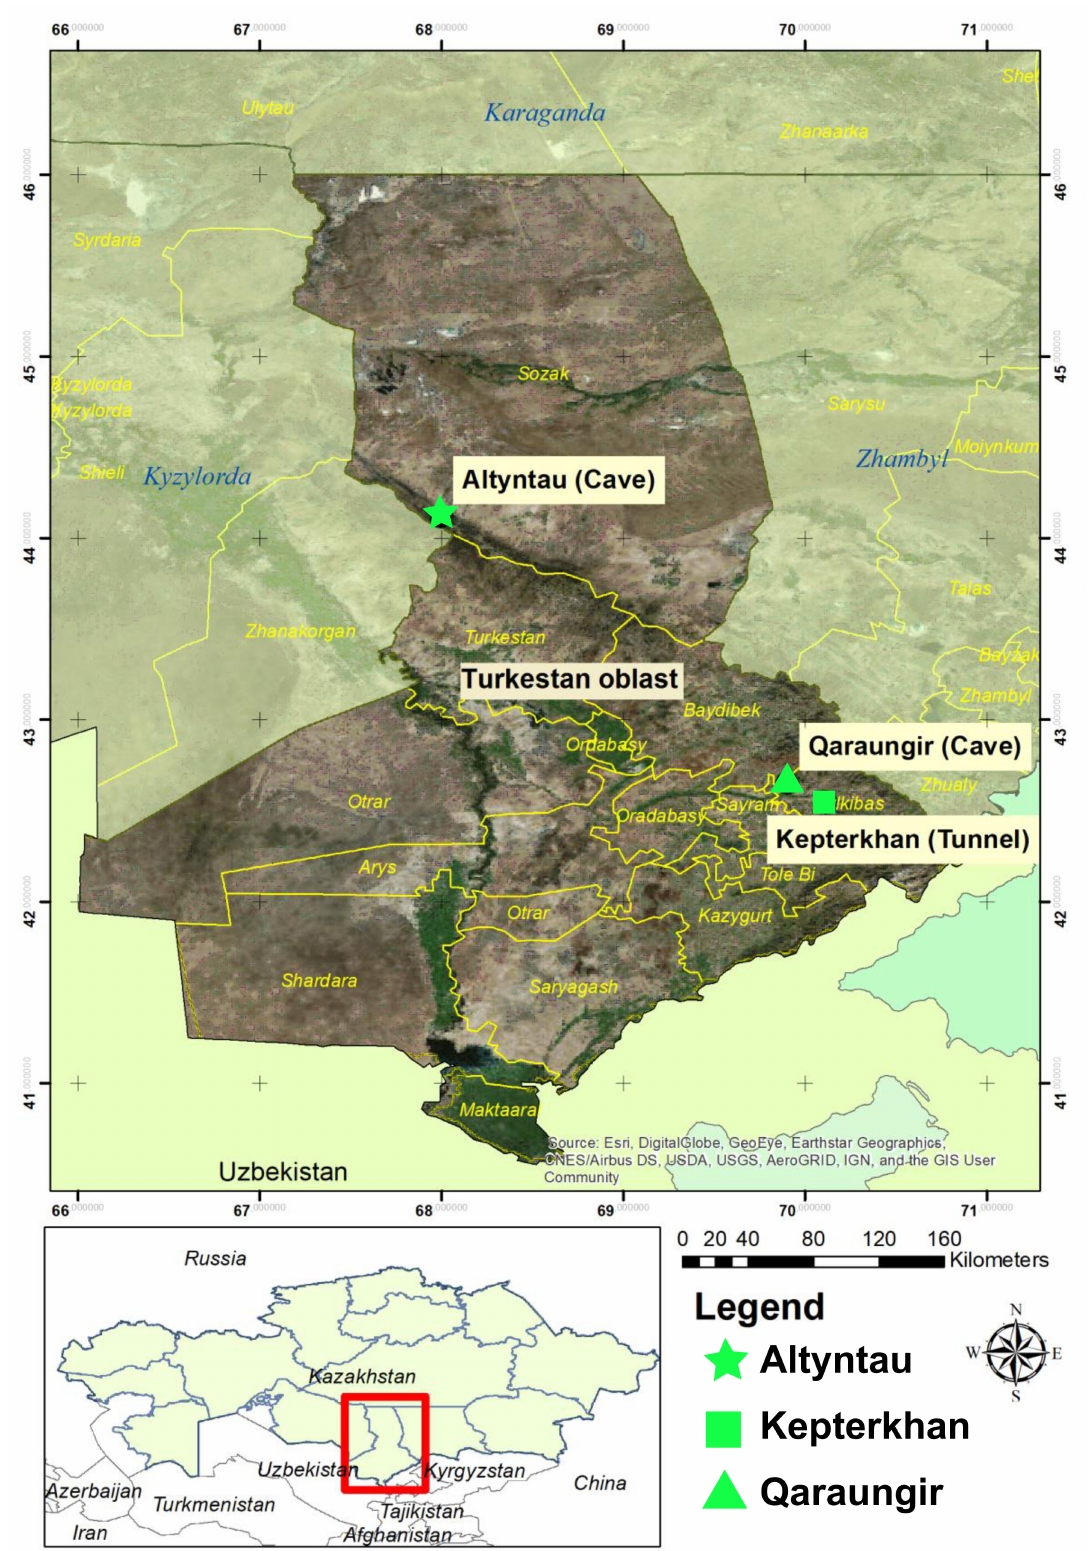
Figure 1. Geographical map of Kazakhstan showing the global positioning system (GPS) locations of three collection sites in this study. The green figures correspond to the sampling sites and are referenced next to the sequence name in Figure